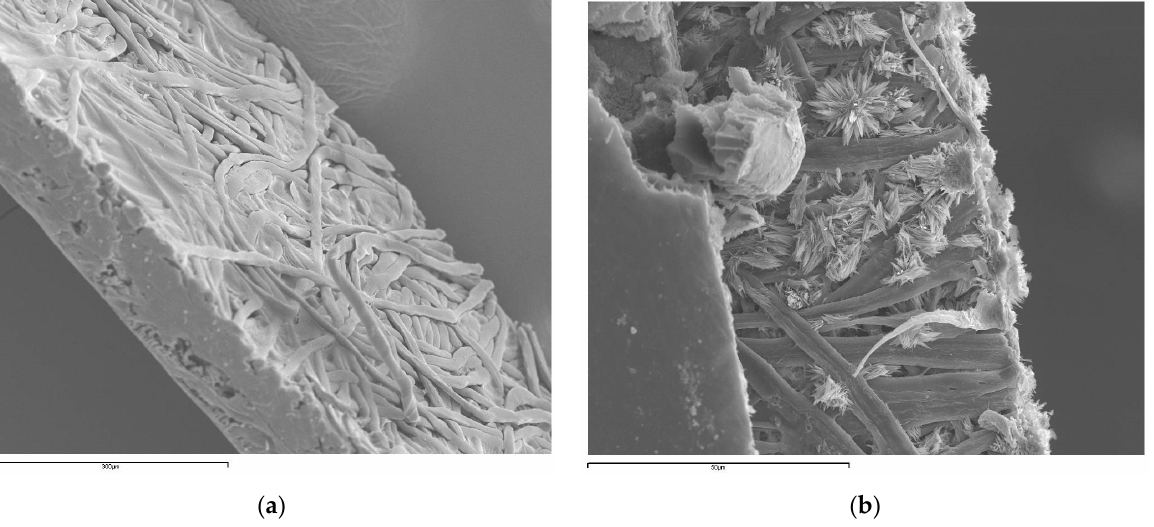
Figure 7. PERVAP TM 1131 membrane SEM pictures: ( a ) new membrane, ( b ) membrane with lactic acid crystals after pervaporation.